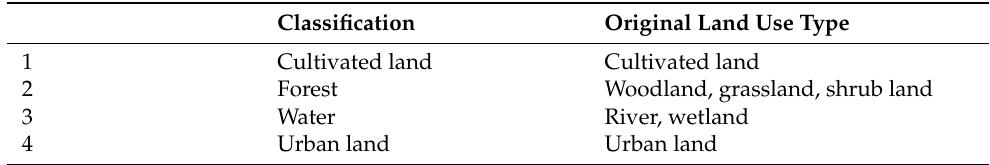
Table 2 for details of the reclassification system of land use: Table 2. Land use classification system in this